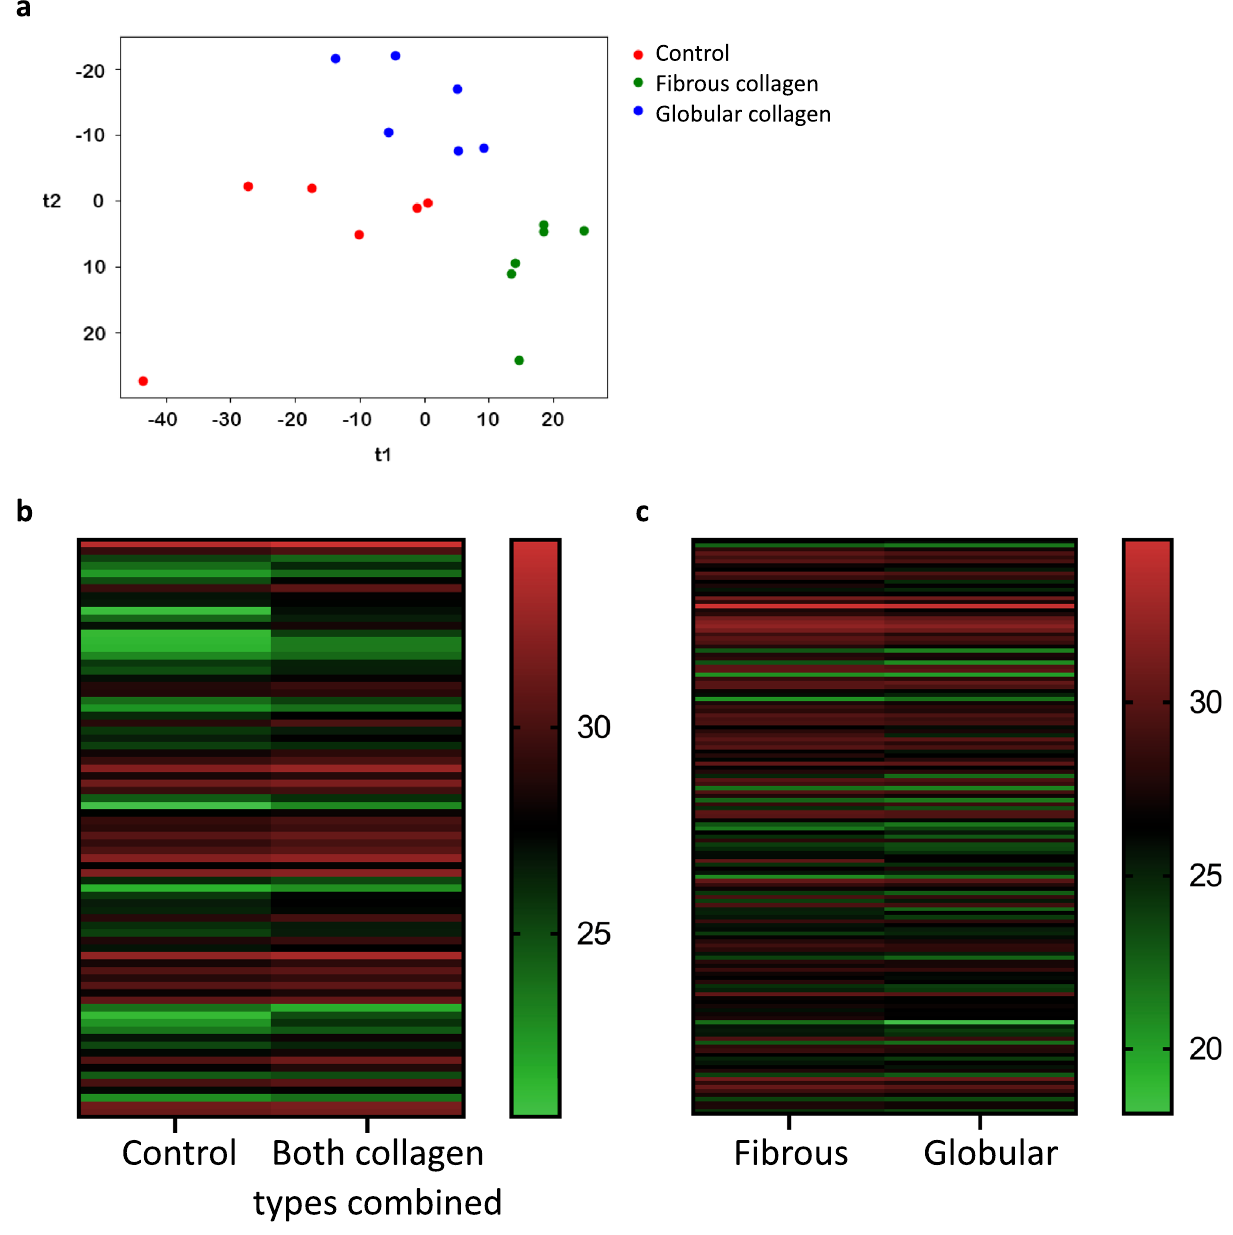
Figure 1. Effect of culturing conditions on the protein expression profile of macrophages. Alveolar macrophages were cultured on uncoated, globular collagen-coated or fibrous collagen-coated tissue culture plastic (n = 6). ( a ) Partial least squares-discriminant analysis plot of alveolar macrophages in the different conditions showing that the 3 conditions cluster separately. ( b ) Heatmap of 77 proteins that were differentially expressed (p < 0.025) between uncoated and collagen type I-coated conditions (fibrous and globular pooled). ( c ) Heatmap of 142 proteins that were differentially expressed (p < 0.05) between macrophages cultured on fibrous or globular collagen. Expressed as Log2 of the median values and statistically tested with an unpaired ( b ) or a paired ( c ) Wilcoxon